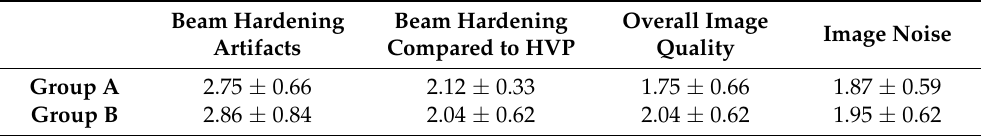
Table 3. Subjective image quality scores of Group A (dose modulation on) and Group B (dose modulation off). Data are mean ± standard